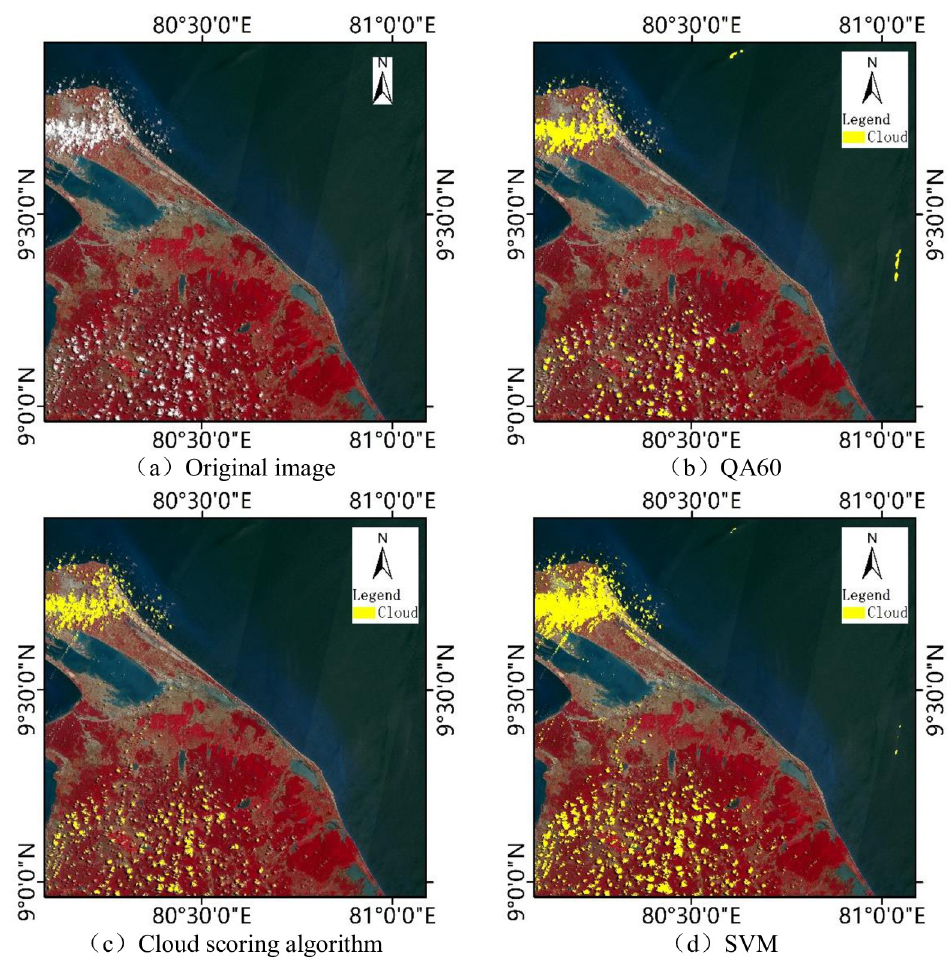
Fig 2. Cloud detection results of site 1 with different